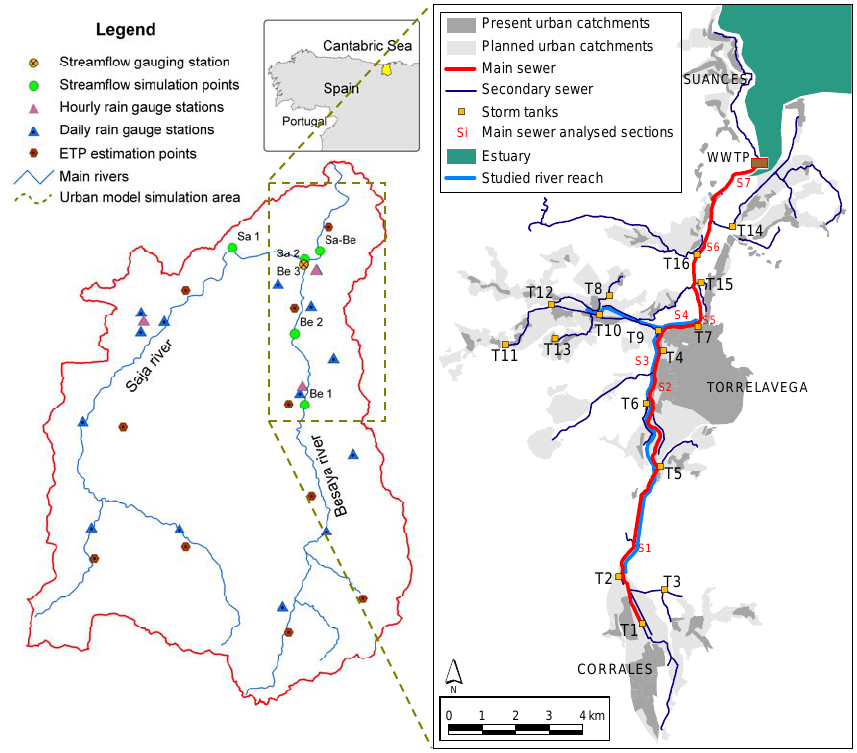
Fig. 1. Left: River basin, main drainage network, rain-gauges, gauging point, PET estimation points and fluvial simulation points. Right: Present urban catchment and future planning, main and secondary sewers, storm tanks and main sewer sections location, and